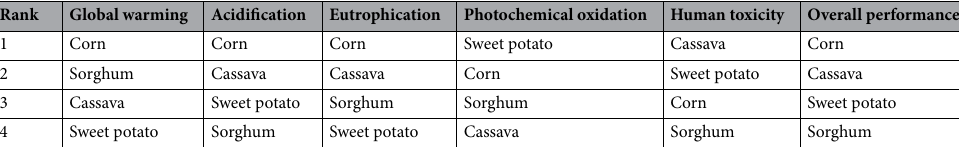
Table 7. Ranking of the environmental impact of the selected bioethanol